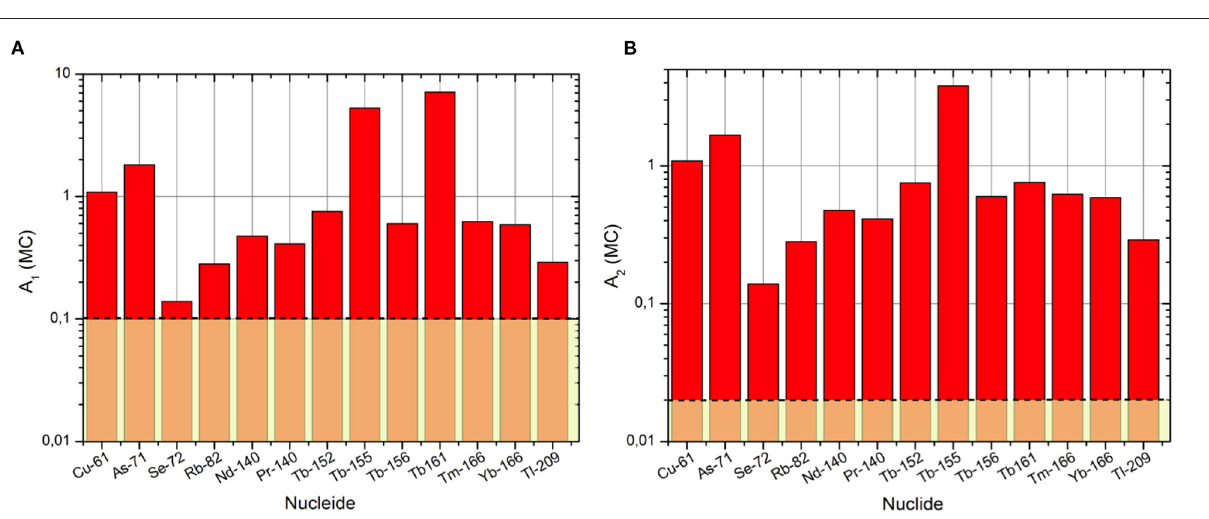
FIGURE 7 | Simulated values with the Monte Carlo technique (MC) for A 1 (A) and A 2 (B) compared with the values of the Regulation (yellow rectangle) for the electron